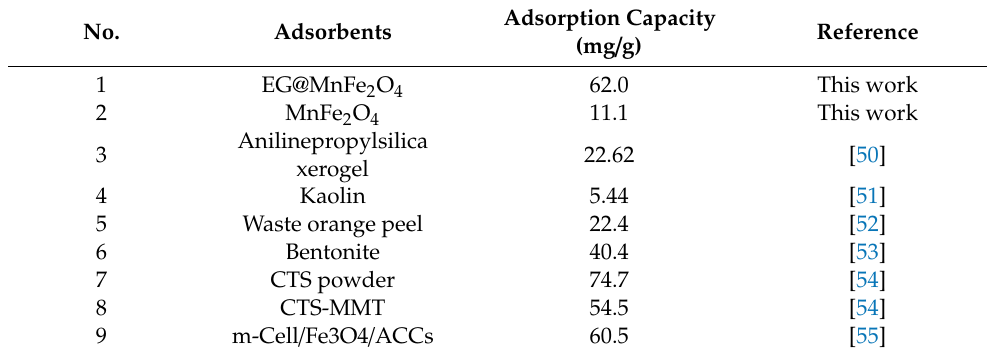
Table 7. Comparation of adsorption capacity using various